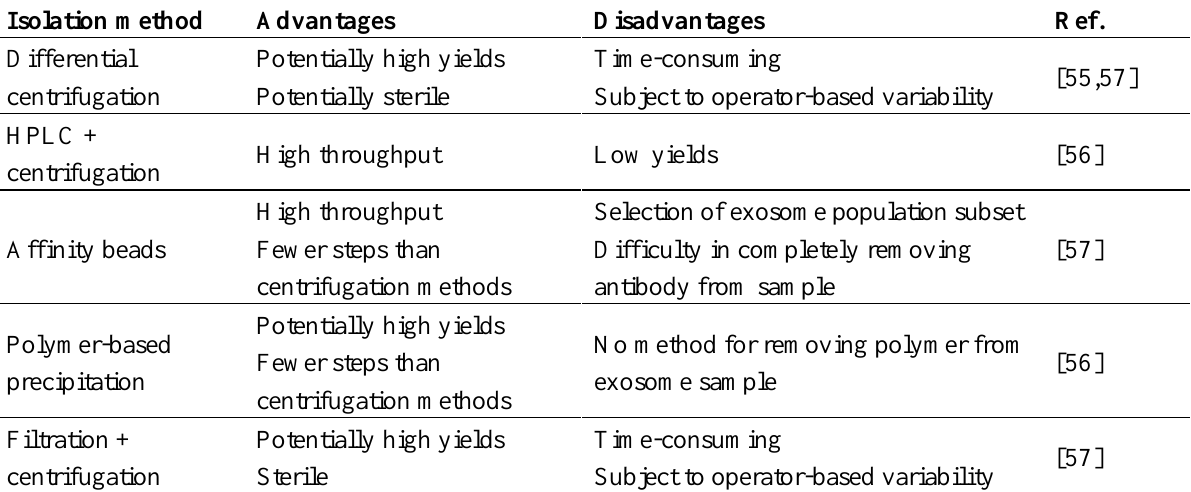
Table 2. Exosome isolation